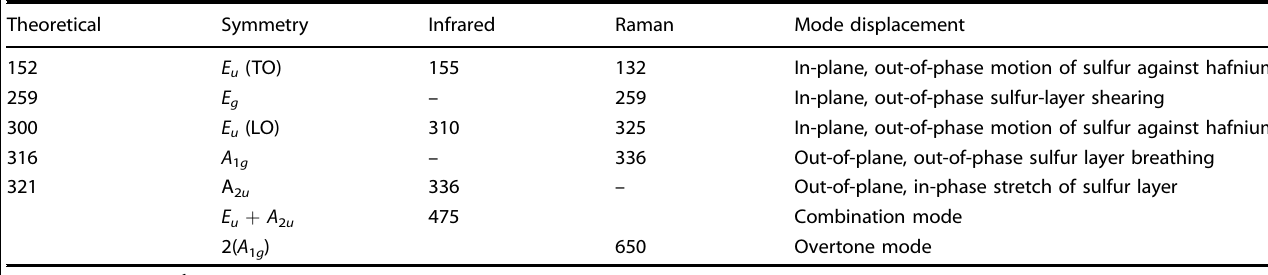
Table 1. Vibrational mode assignments of 1T-HfS 2